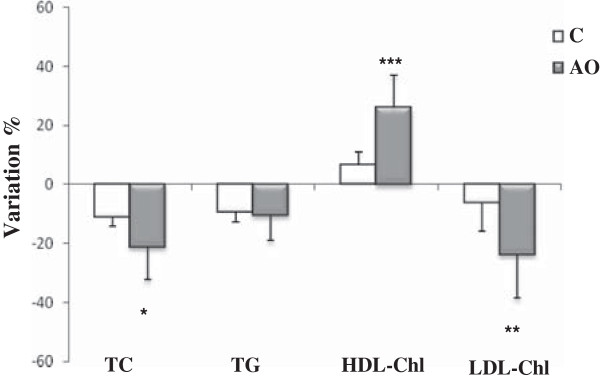
Variations in different plasma lipid markers after 3 weeks of nutritional intervention with argan oil. Data are the percentage variation of the lipid parameters between the two periods. Comparisons are made between the variation in the two groups of patients (C: control group; AO: argan oil group). TC: total cholesterol; TG: triacylglycerol ; HDL-Chl : high density lipoprotein cholesterol; LDL-Chl: low density lipoprotein cholesterol. After a one-way ANOVA, Student-Newman-Keuls multiple test, a comparison was made between the two groups of patients. ***: p = 0.01; **: p = 0.02; *: p = 0.04.